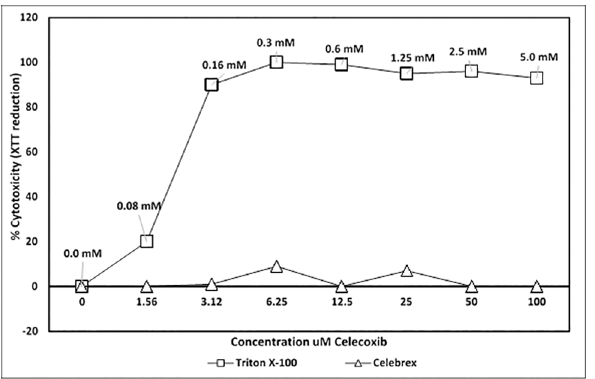
Fig 10. Celecoxib-treatmentsbelow 100mM are not cytotoxic to HEK-TLR4 cells. The HEK reporter cells were cultured overnightin dilutions of celecoxib(triangles)or Triton X-100 (control; squares). The X axis shows the final concentrations of celecoxib in the culture media and the numerical labels above the square data labelsshow the mM concentrations of Triton X-100 used in the positive cytotoxic controls. Cell viability was tested using XTT + menadione. Substrate (XTT) conversionwas monitoredand measuredas OD 490 duringa 12 h incubation. Net absorbance was adjustedby subtractionof media only (acellular) absorbance and % cytotoxicity was computedas an absorbance quotient using treated cell XTT conversion/non treated cell XTT conversionx 100%. ComputedSEM were negligibleand while shown in the graph, they are hidden by the symbols.